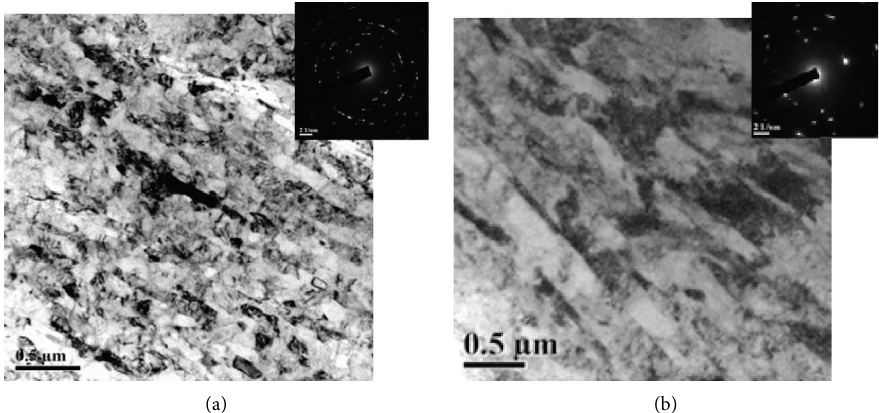
Figure 10: Te workpiece microstructure after the TE and the second stage of rolling ( h � 2.5 mm, heating 350 ° C): (a) rolling after the TE; (b) rolling of the extreme part of the sample without complete processing by the